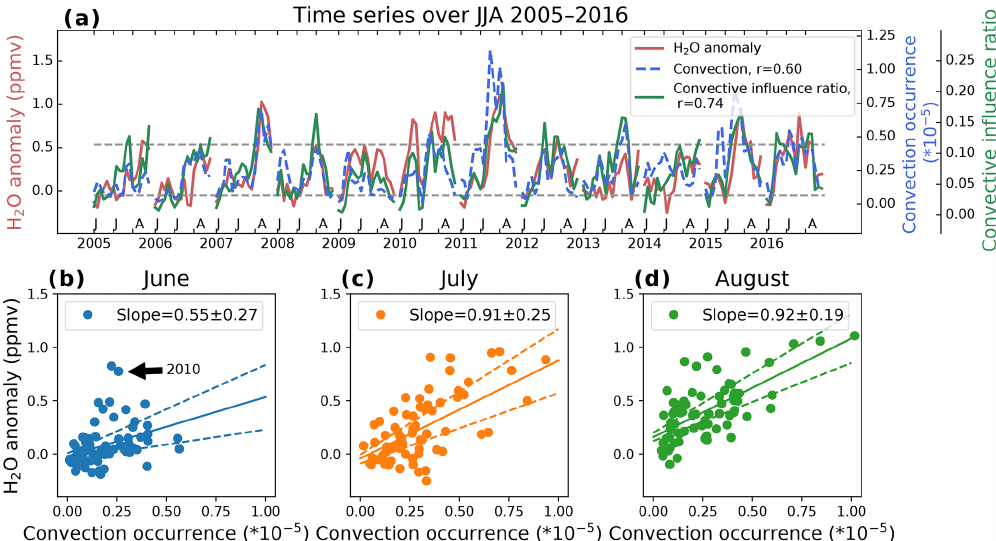
Figure 1. (a) Time series of 100hPa (red line) MLS water vapor anomaly (zonal mean removed), (blue line) convective occurrence from GridRad, and (green line) the effective convective influence ratio in the back trajectory experiments. All data are 5d (H 2 O anomaly and influence ratio) or 10d (convection) averages over the NA region (25–50 ◦ N, 70–130 ◦ W) during June–August 2005–2016. For the convective frequency, we use linear interpolation to estimate the value at 100hPa. The effective convective influence ratio is the fraction of the MLS observations that encounter deep convection and do not get further dehydrated, as determined by the back trajectory calculations. (b–d) Joint distribution of convection and water vapor time series during 2005–2016 divided into (b) June, (c) July, and (d) August. Solid lines show the linear fit, and dashed lines show the 95% significant level margin of error of the slope bar (accounting for autocorrelation). To account for the time for the water vapor to spread out, each data point is a 10d average of convection, with water vapor averaged over the last 5d of the averaging period for